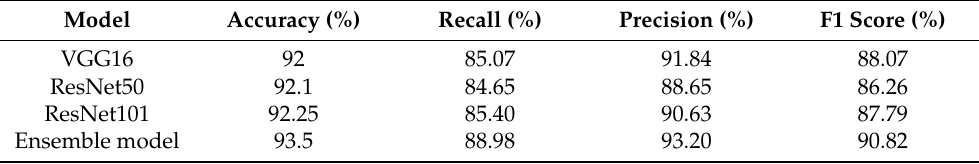
Table 5. Performance evaluation metrics of the three models on the augmented